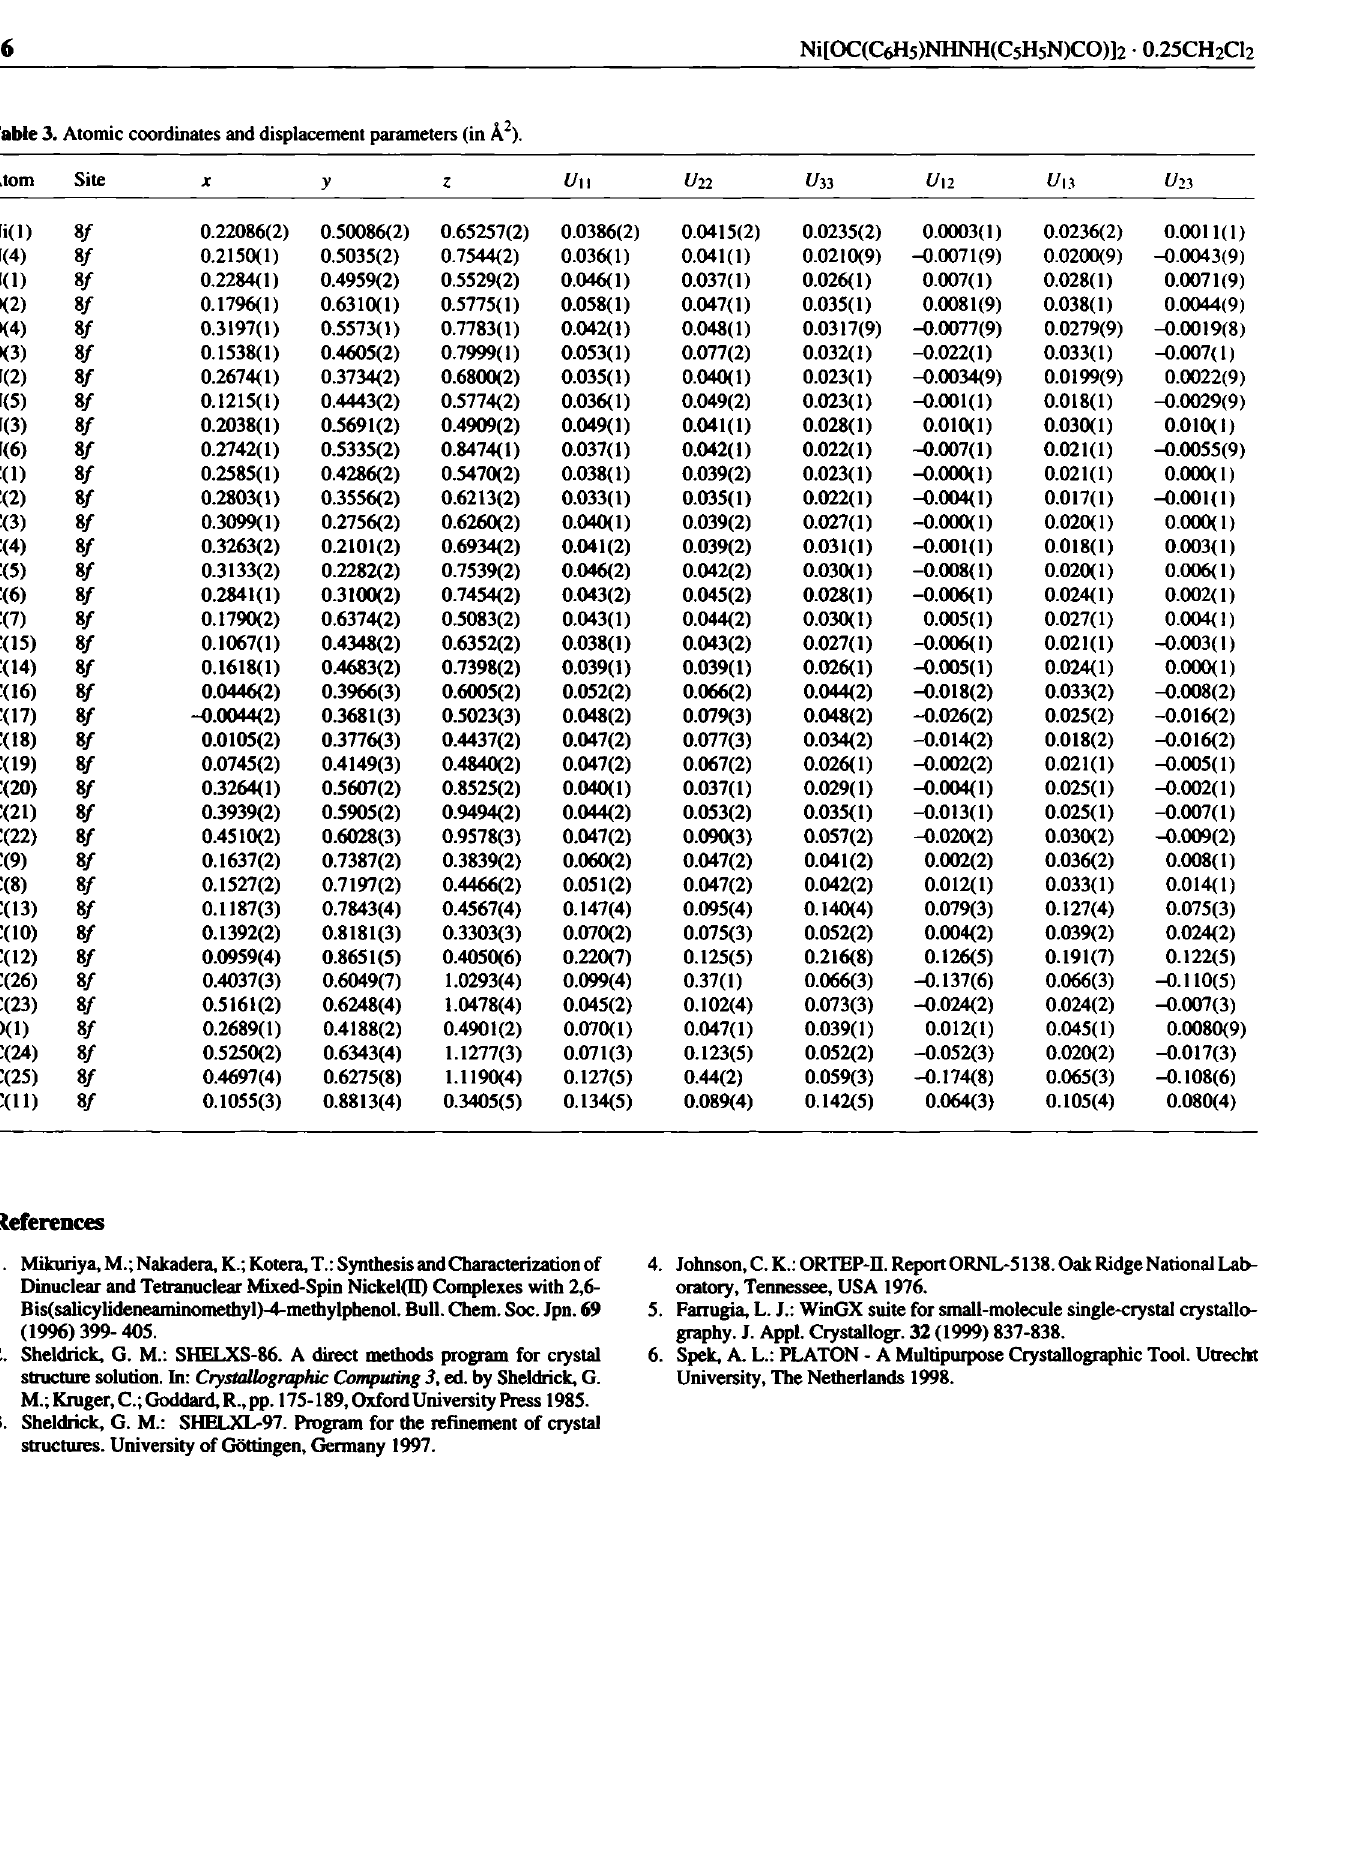
Table 3. Atomic coordinates and displacement parameters (in Â 2